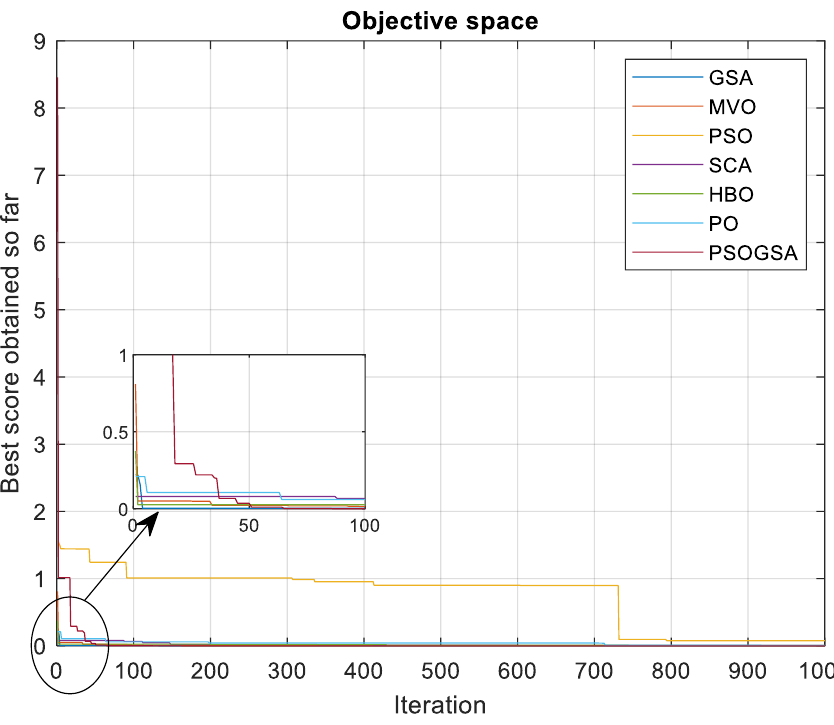
Figure 8. The convergence curve of the monocrystalline MSDM. Table 5. The MSDM calculation error, mean and standard deviation for the monocrystalline PV cell.